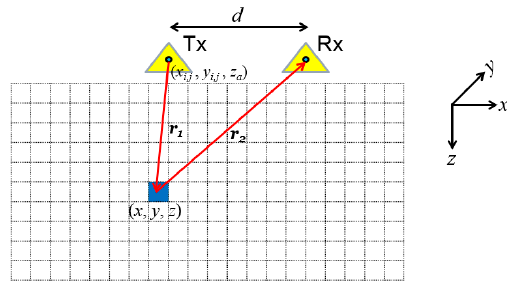
Figure 5. Geometry of the bistatic model for the SAR processing.